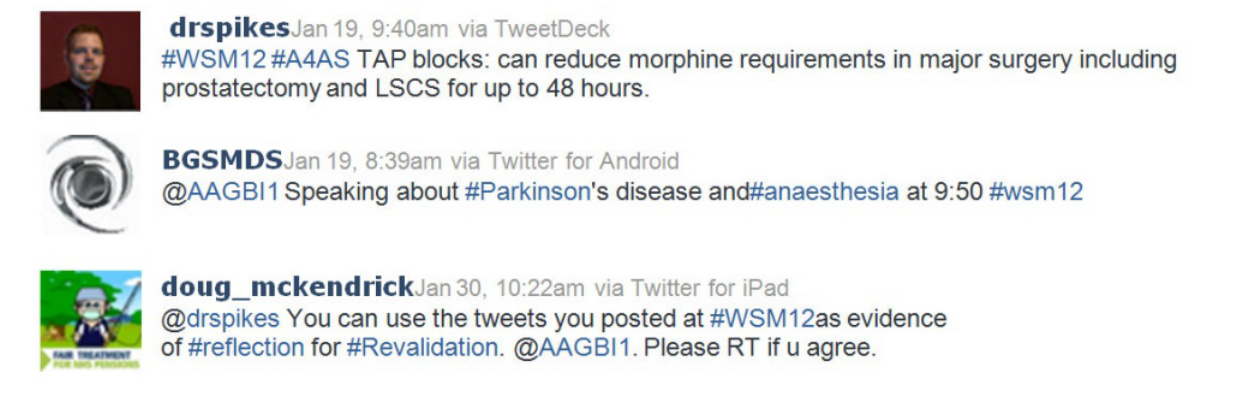
Figure 4. A selection of tweets posted during the January 2012 Association of Anaesthetists of Great Britain and Ireland (AAGBI) Winter Scientific Meeting. Top: The use of Twitter to post a learning point; Middle: a tweet posted by a speaker; and Bottom: part of a discussion suggesting the use of tweets as a form of reflection for revalidation